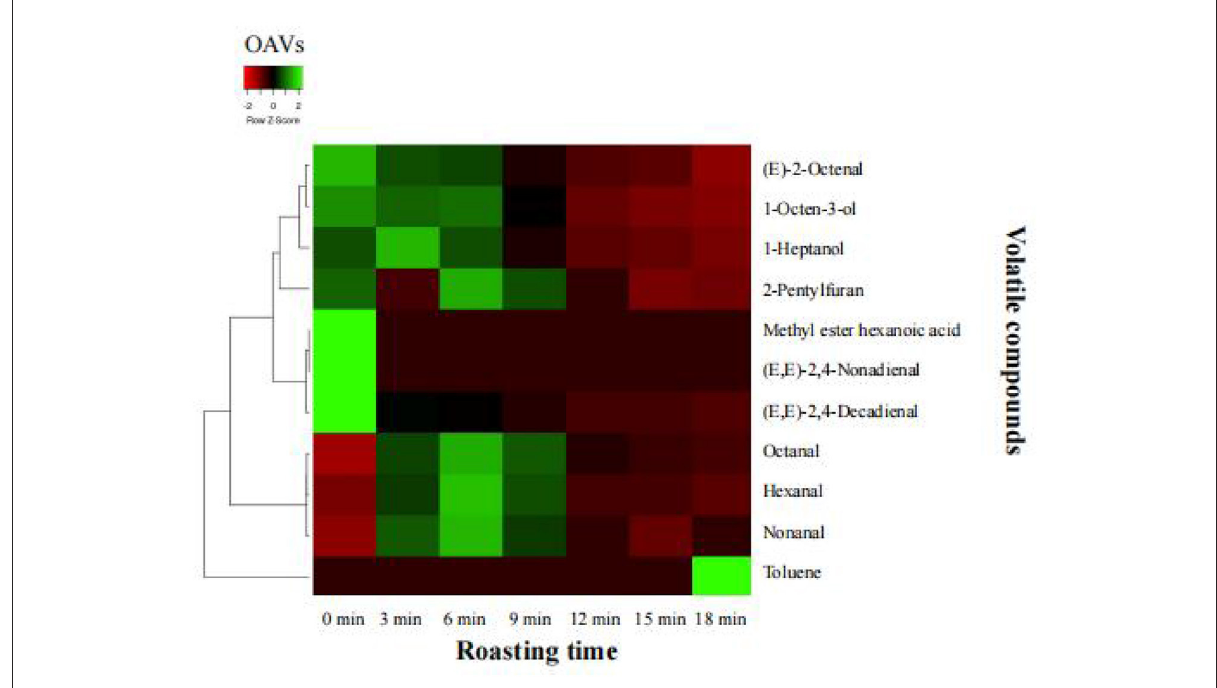
FIGURE3 Changes of OAVs of key aroma compounds (OAVs > 1) in the roasted beef during roasting.